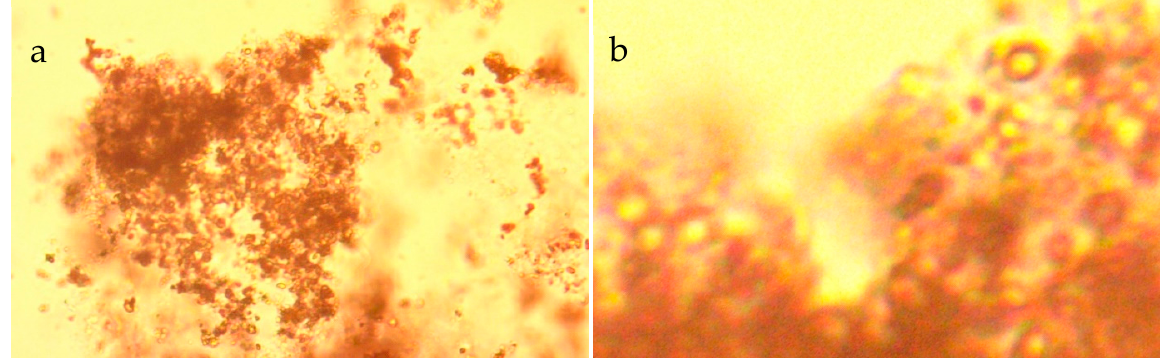
Figure A3. n-Fe(b)@bluecrop polyphenol polymer. ( a ), Agglomerated gel, showing a cellular struc- ture where the gel forms from the aggregation of colloidal spheres. Transmitted light, field of view = 0.26 mm. Manufacture ratio = 1 g FeSO 4 : 20 cm 3 blueberry (variety: Blue Crop) juice/extract; ( b ), Enlargement of Agglomerated gel, showing construction from the agglomeration fluid filled polymer spheres. Transmitted light, field of view = 0.04 mm. Individual (pre-aggregation) colloidal sphere sizes: Average = 1.39 microns; standard deviation = 0.50; 1st quartile = 1.07 microns; median = 1.33 microns; 3rd quartile = 1.60 microns;.